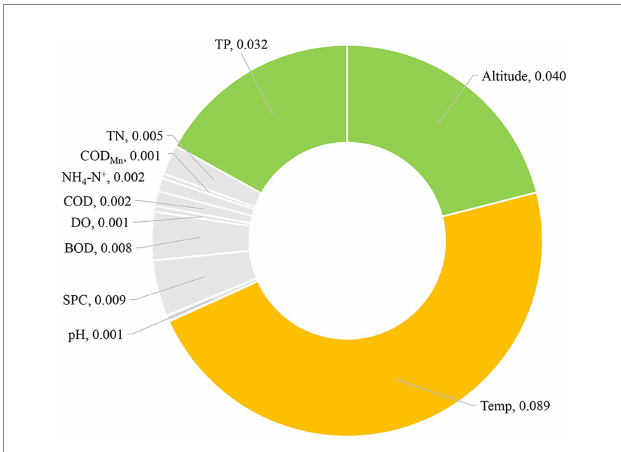
FIGURE 4 Eta-squared value of different environmental factors for the presence/ absence of colonial volvocine